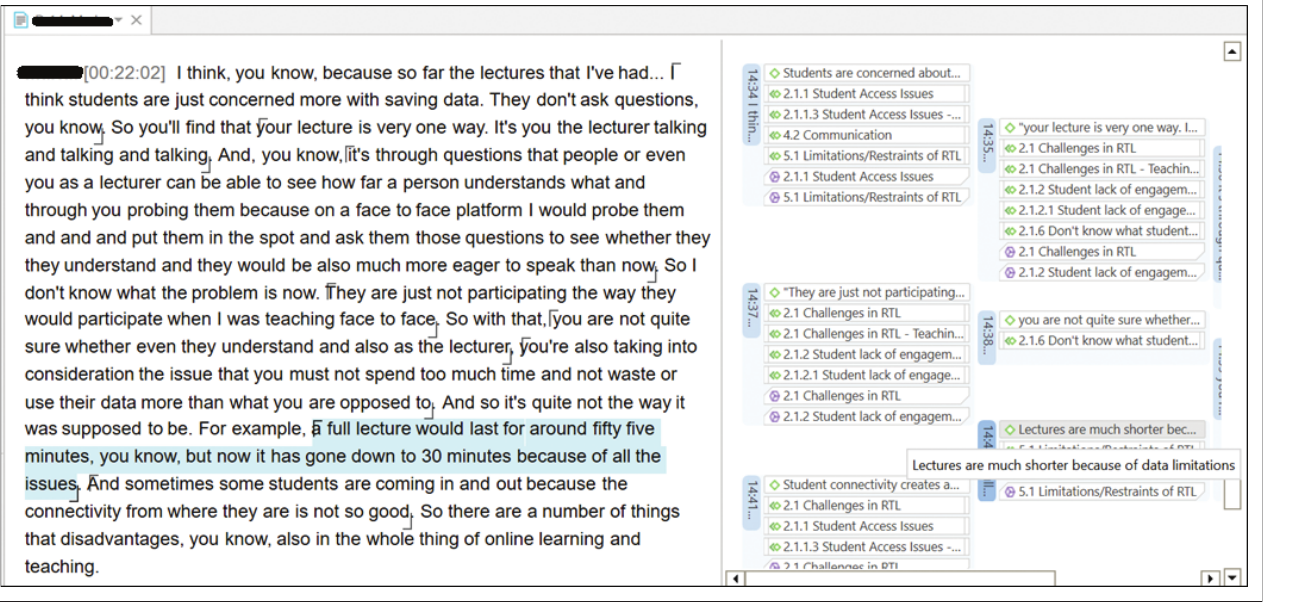
FIGURE 1: Example of a code being allocated to an excerpt of